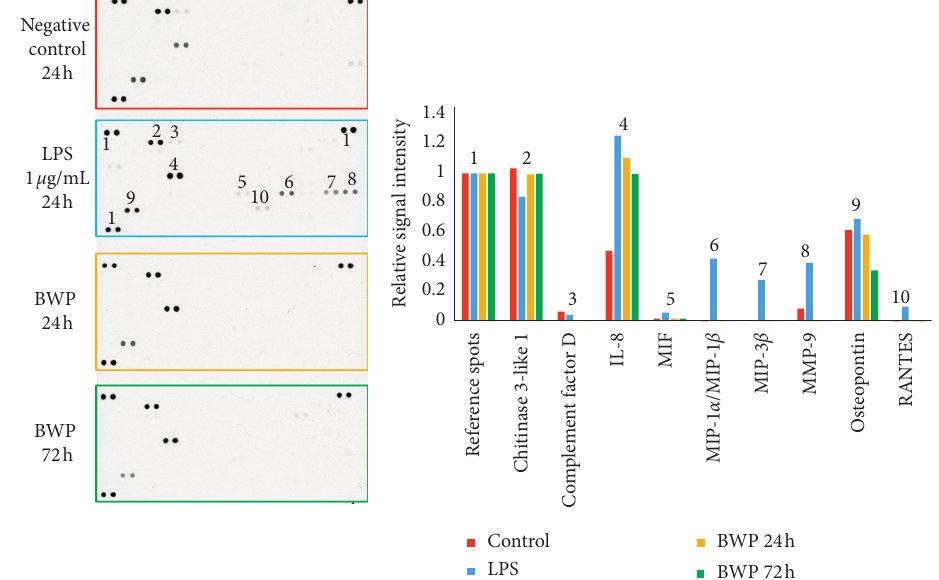
Figure 2: Cytokine array screening assay results. Left: scan of a 10-minute exposed film. Right: relative intensities for positive signals. Coordinates of positive signals are identified by the numbers on the LPS array.